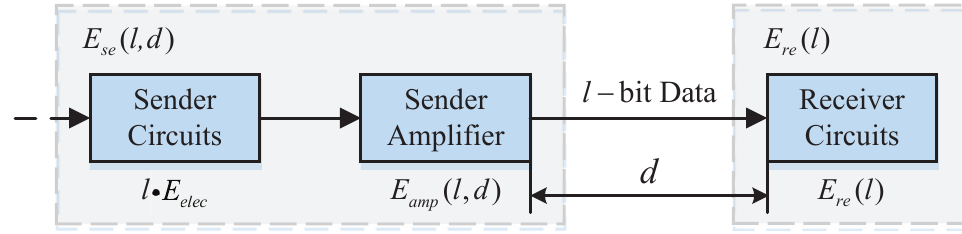
Figure 3. The energy consumption model of nodes in